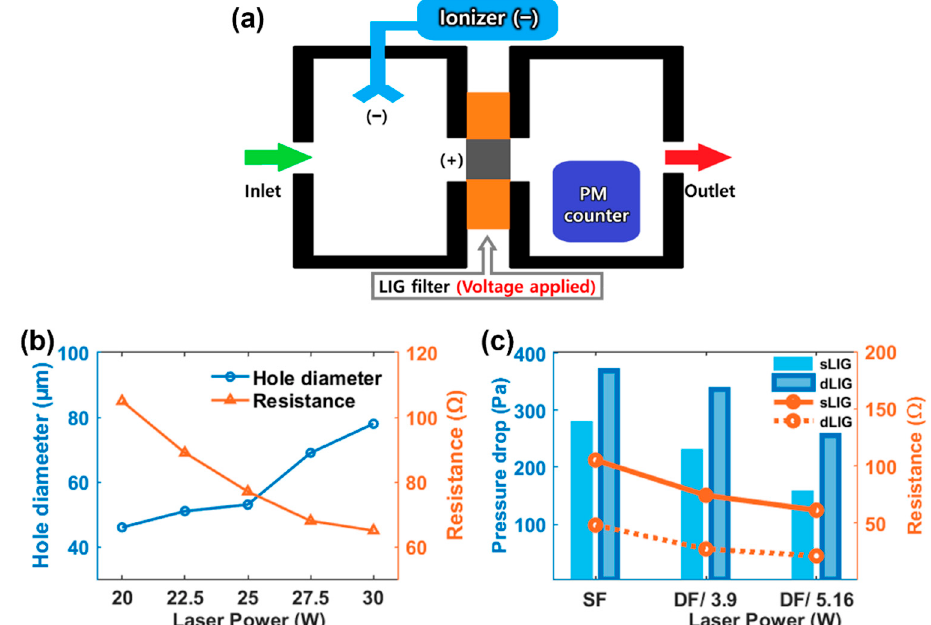
Figure 4. ( a ) Schematic of the air filtration setup. The PM counter sensor is placed in the right side of the chamber, while the PM (incense) is introduced into the left side of the chamber. The LIG filter is sandwiched between the two chambers; ( b ) Hole size and electrical resistance of sLIG filter samples drilled with different laser powers; ( c ) Pressure differences and resistances of single-faced (SF) and double-faced (DF) LIG filters fabricated with different back-side laser scanning powers: 3.9 and 5.2 W.